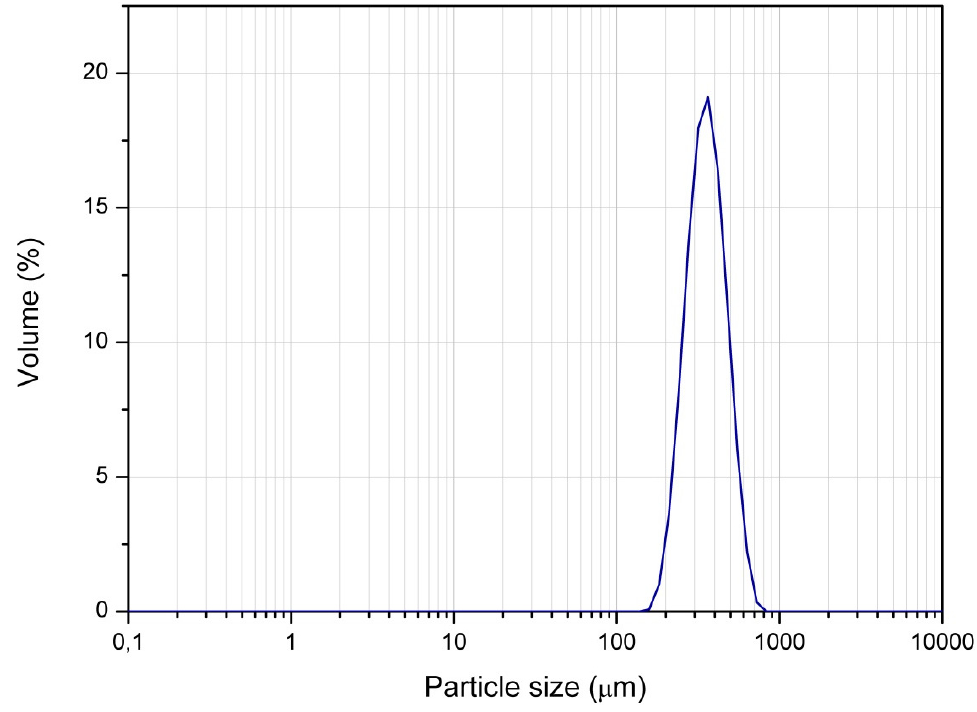
Figure 3. Particle size distribution of olivine.